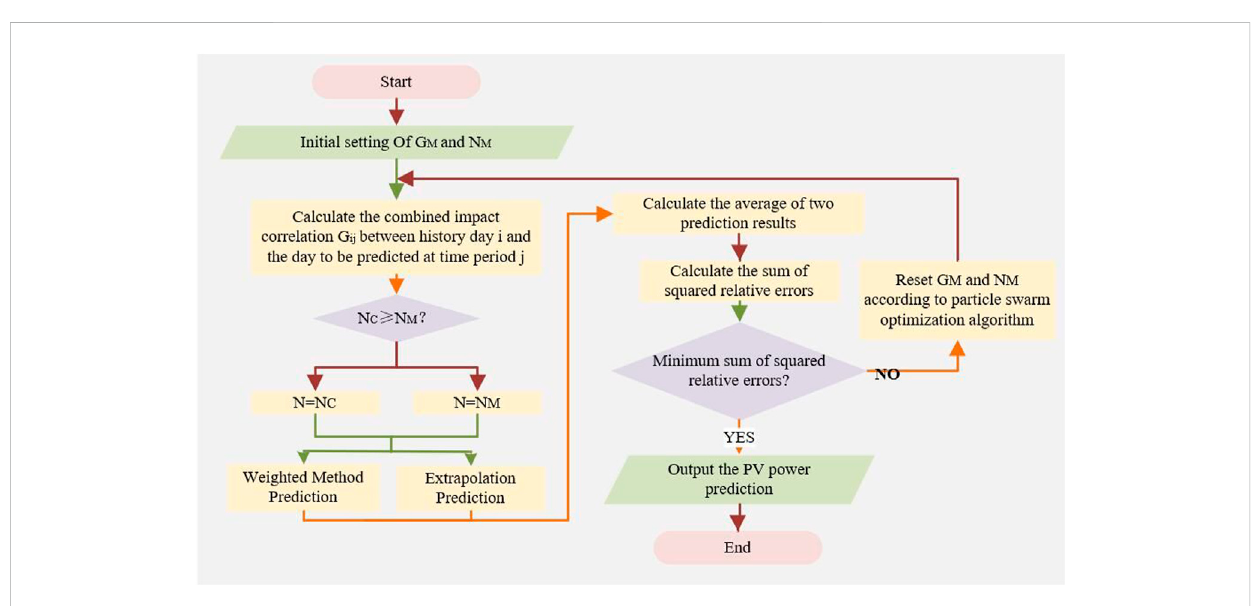
Photovoltaic power prediction fl ow